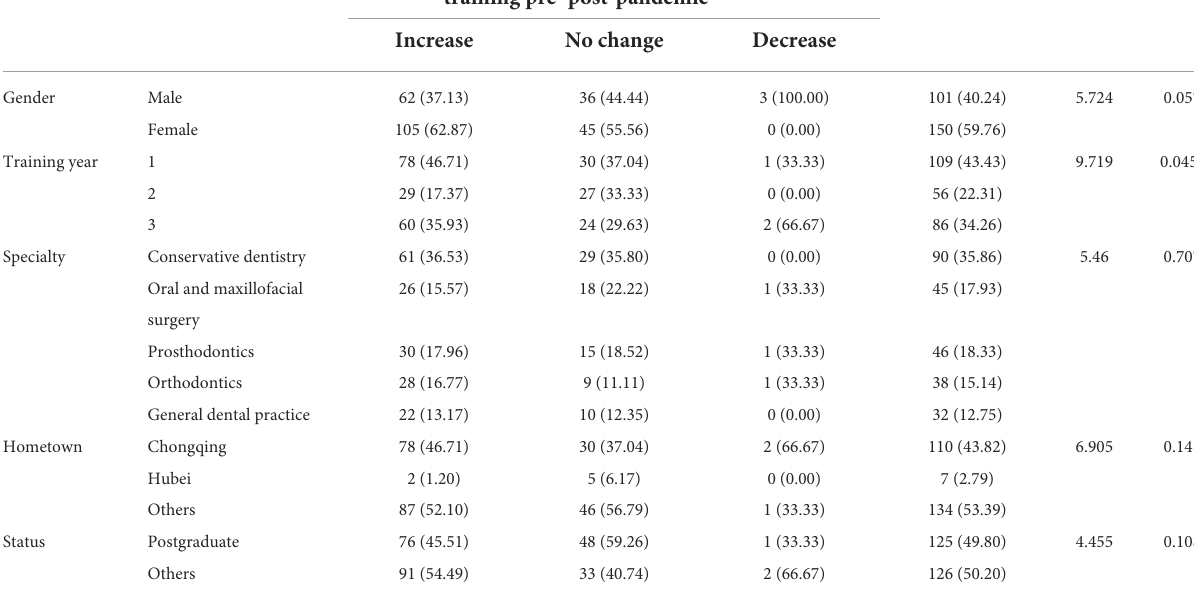
TABLE 3 Emphasis of trainees on infection control training pre–post-pandemic.